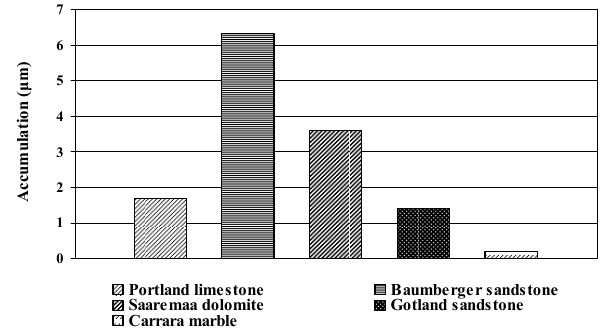
Fig. 16. Accumulation of natural stone materials exposed for one year under sheltered